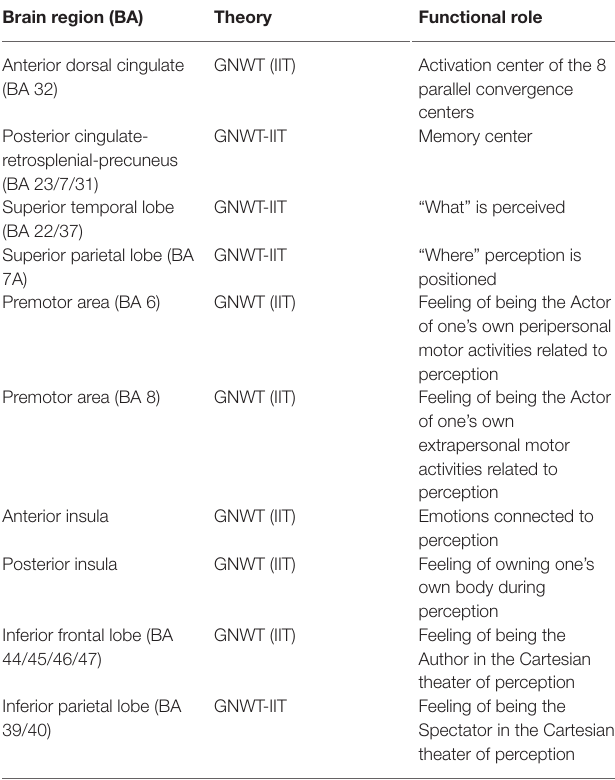
TABLE 1 | Ten neural correlates of